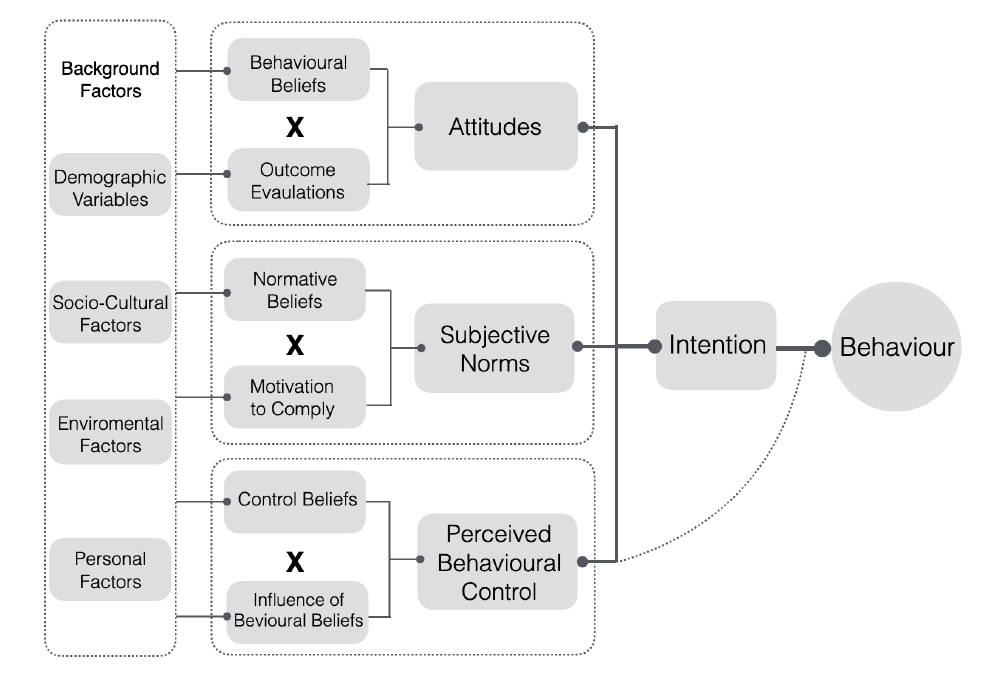
Figure 1. The Theory of Reasoned Action and Theory of Planned Behavior (the figure was created by using resource of Ajzen and Fishbein, 2005